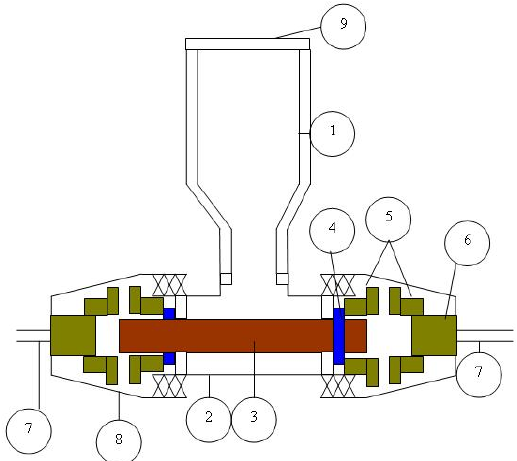
Fig. 3 represents the schematic diagram of the model domain used in the simulation. Feed solution containing a mixture of 90 wt. % Ethanol and 10 wt. % water flows tangentially through the upper side of the membrane system (z=0). The